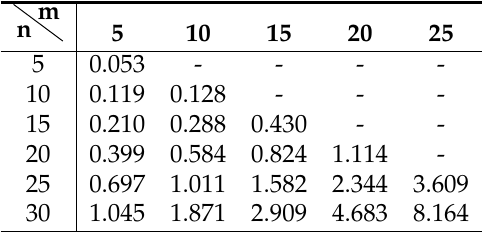
Table A2. Total solution time using Chebyshev polynomials in seconds for Problem